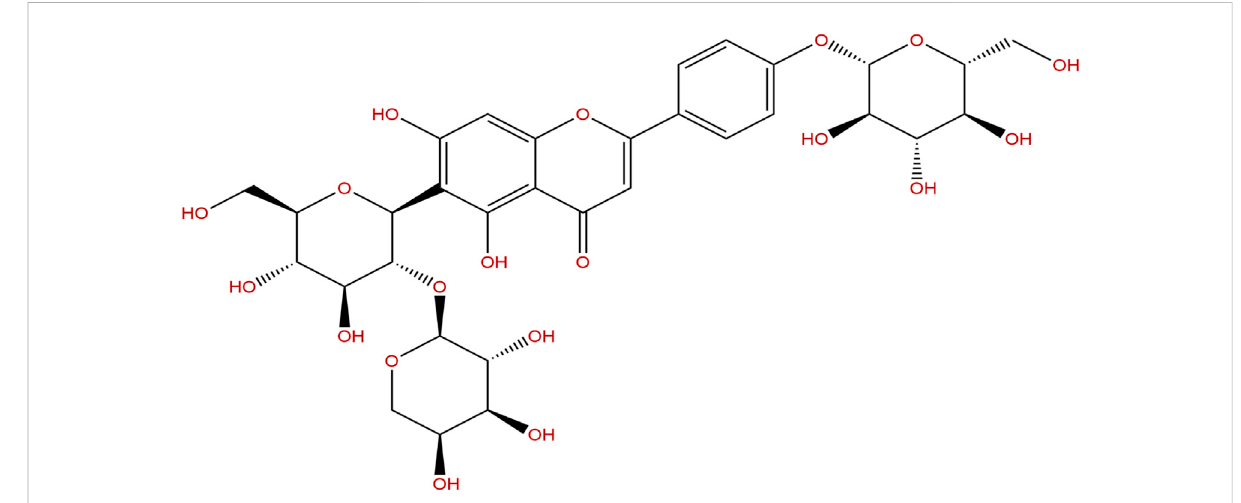
Chemical structure of